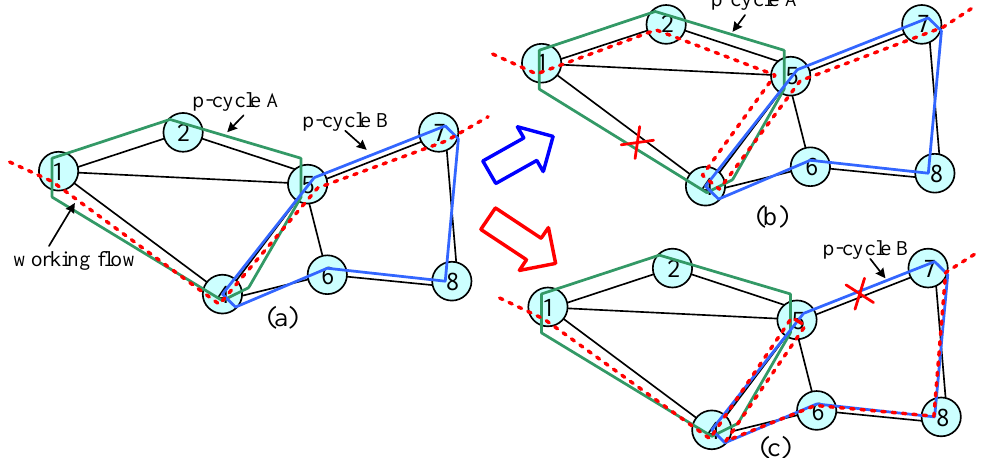
Figure 5. The p-cycle scheme: ( a ) p-cycles configuration; ( b ) a failure occurs at p-cycle A; ( c ) a failure occurs at p-cycle B. occurs at p-cycle